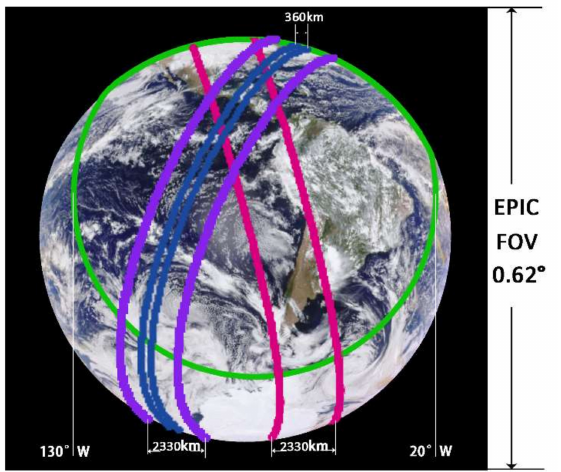
Figure 1. Earth Polychromatic Imaging Camera (EPIC) enhanced Red-Green-Blue (RGB) image of the sunlit Earth taken on 15 January 2017 at 18:37:04 Greenwich mean time (GMT) (https://epic. gsfc.nasa.gov/enhanced?date=2017-01-15). Areas between purple and red lines are Terra and Aqua Moderate Resolution Imaging Spectroradiometer (MODIS) 2330 km wide swaths. Blue lines depict a 360 km swath of the Multi-Angle Imaging SpectroRadiometer (MISR) sensor on the Terra platform. Terra MODIS and MISR cross the equator at 10:30 local solar time (LST) while Aqua MODIS sees the Earth at 13:30 LST. A fixed sampling area of the NASA’s Geostationary Operational Environmental Satellite East (GOES-East) is bounded by a green line. MODIS and MISR sensors on low-earth-orbiting platforms acquires radiance data over swaths at a specific LST. The geostationary GOES-East satellite collects data over a specific area of the Earth. Technical details on sensor sampling areas are given in Section